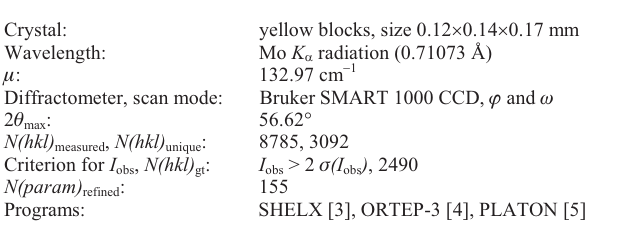
Table 1. Data collection and handling.